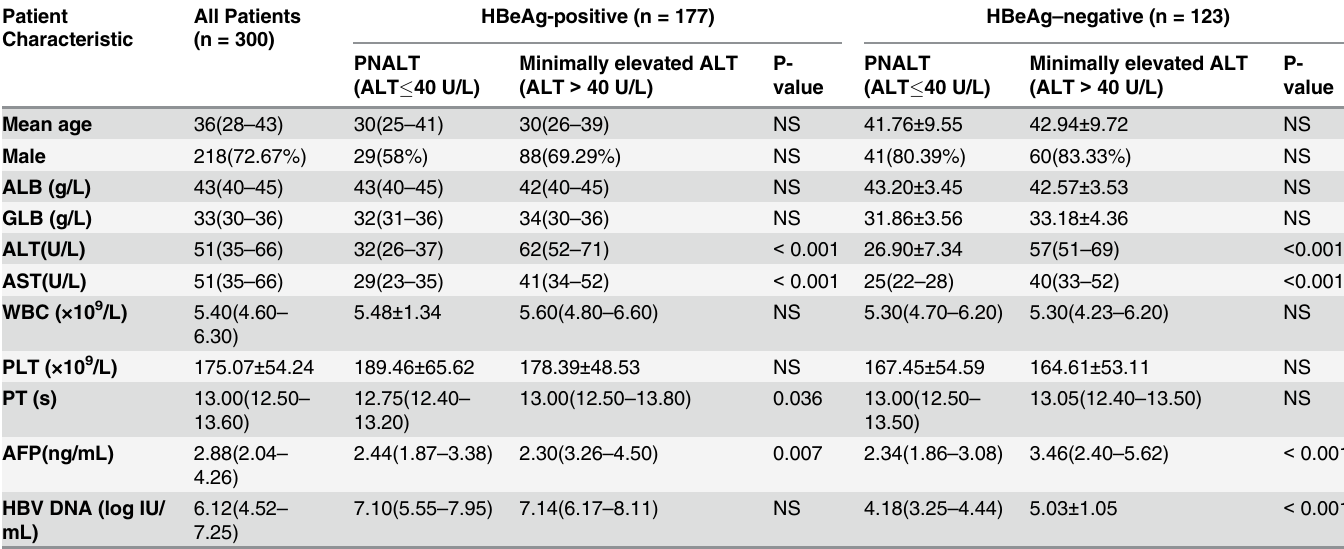
Table 1. Baseline characteristics of 300 chronic hepatitisB patients.